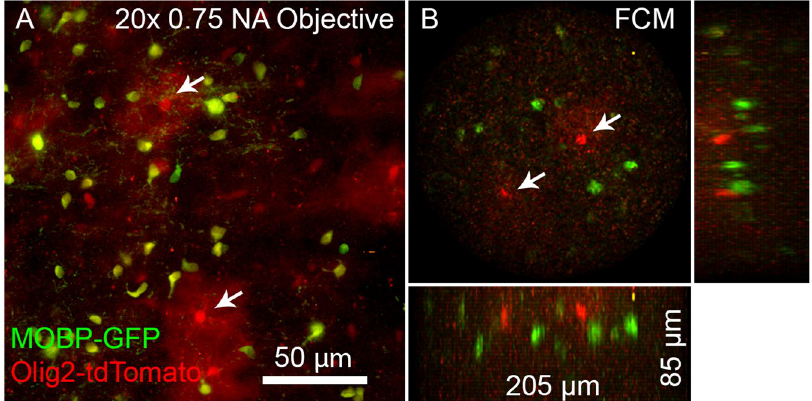
Figure 5. Two-color imaging of GFP-expressing mature oligodendrocytes and tdTomato-expressing oligodendrocyte lineage cells and sparsely labeled astrocytes ( Mobp - EGFP ; Olig2 - Cre ; R26 - lsl - tdTomato triple transgenic mice). ( A ) Maximum intensity projection of a region of brain tissue acquired with a 20x 0.75 NA objective. Yellow cells are oligodendrocytes (Green and Red), while red-only cells are astrocytes and oligodentrocytes cells. Two astrocytes are marked with arrows, and are easily identified by the characteristic bushy morphology and two are marked with arrows. ( B ) The same tissue imaged with the 2P-FCM, using the same detectors, filters, and excitation wavelength. Green and red cells are visible in the field, with likely astrocytes marked by